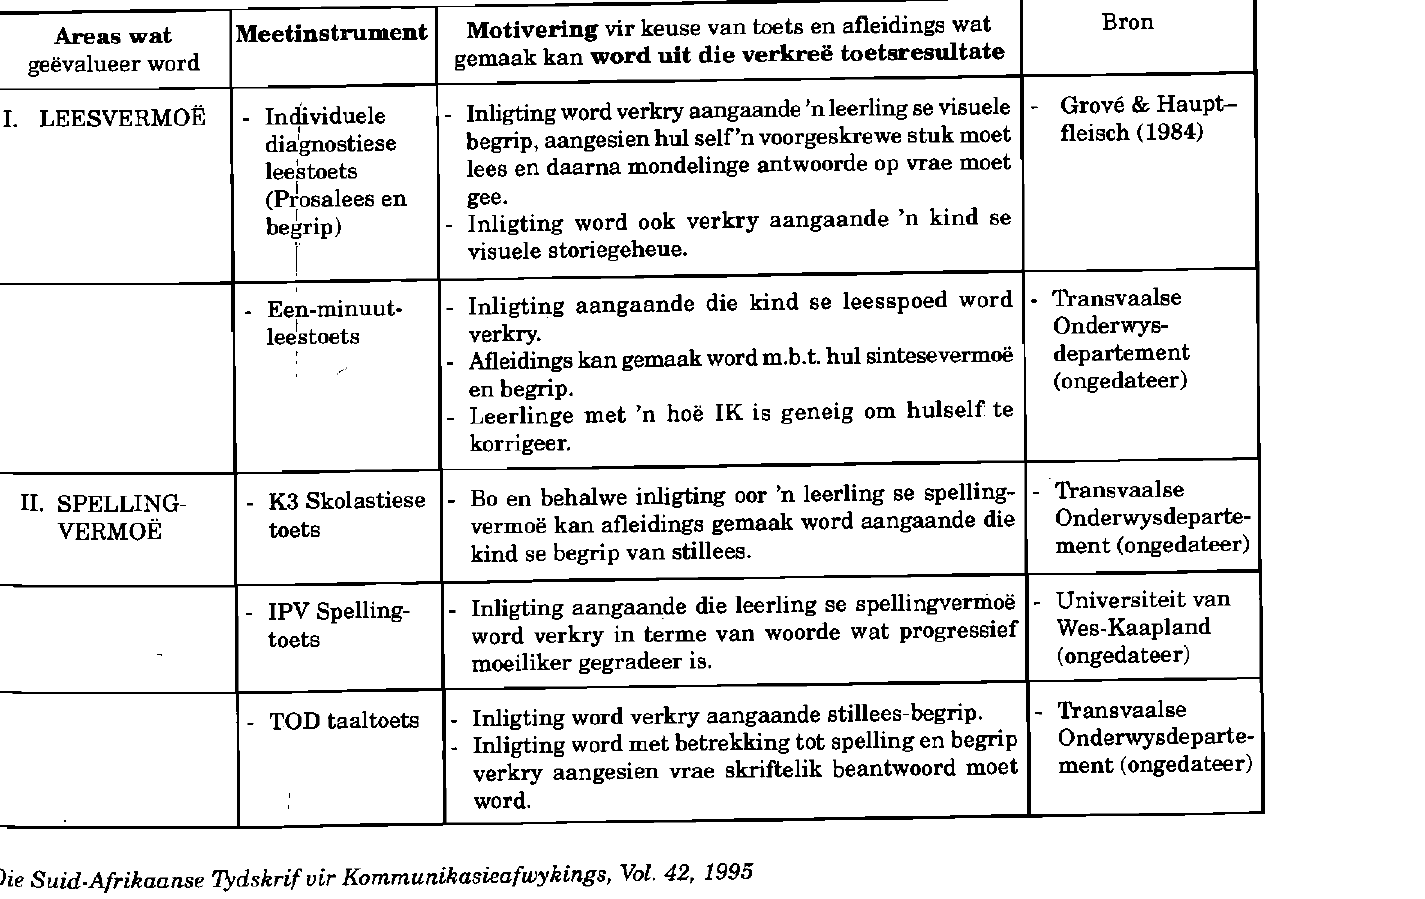
TABEL 3: Evaluasie-areas en meetinstrumente wat geselekteer is om geskrewe taal te evalueer Areas